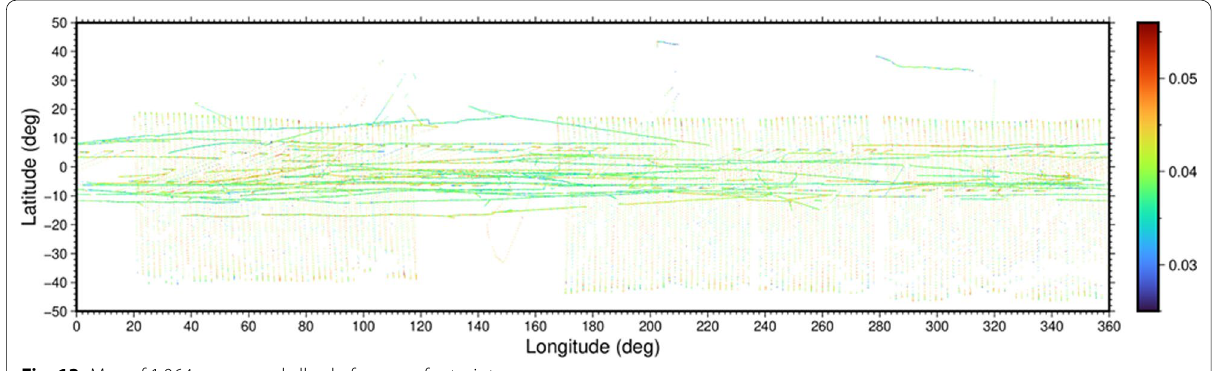
Fig. 13 Map of 1.064 μm normal albedo for every footprint